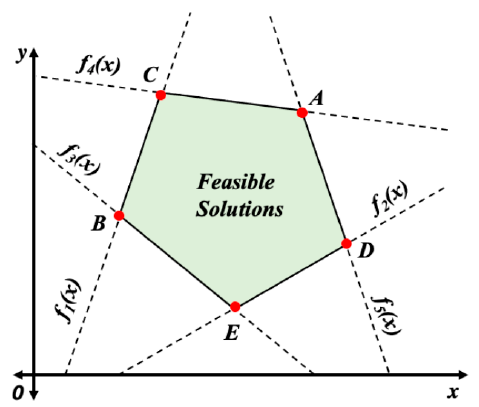
Figure 3. Bounded region of feasible solutions of multiple objective functions.